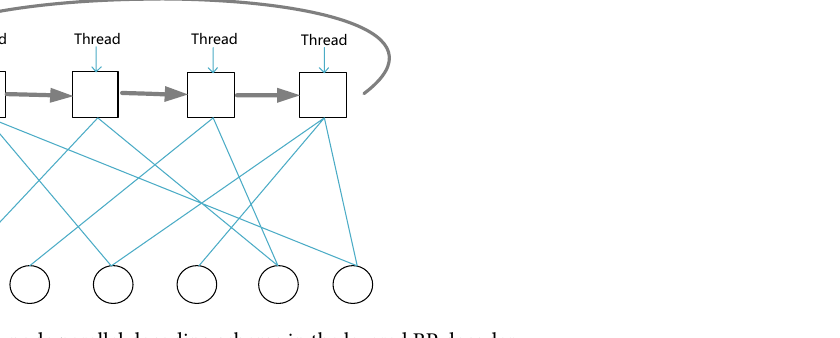
Figure 3. A node parallel decoding scheme in the layered BP